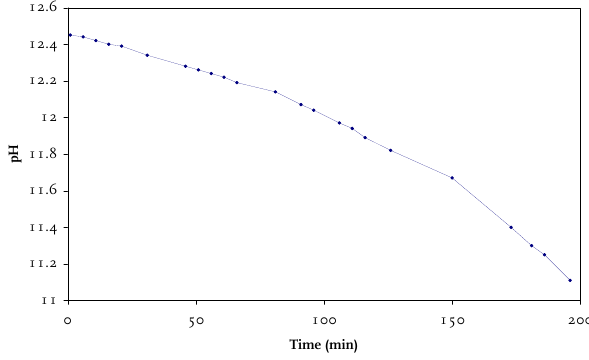
Fig. 5. Laboratory measurements of the pH as function of time. Acidification is caused by CO 2 , see Sect. 3.2. The measurement points are connected with straight